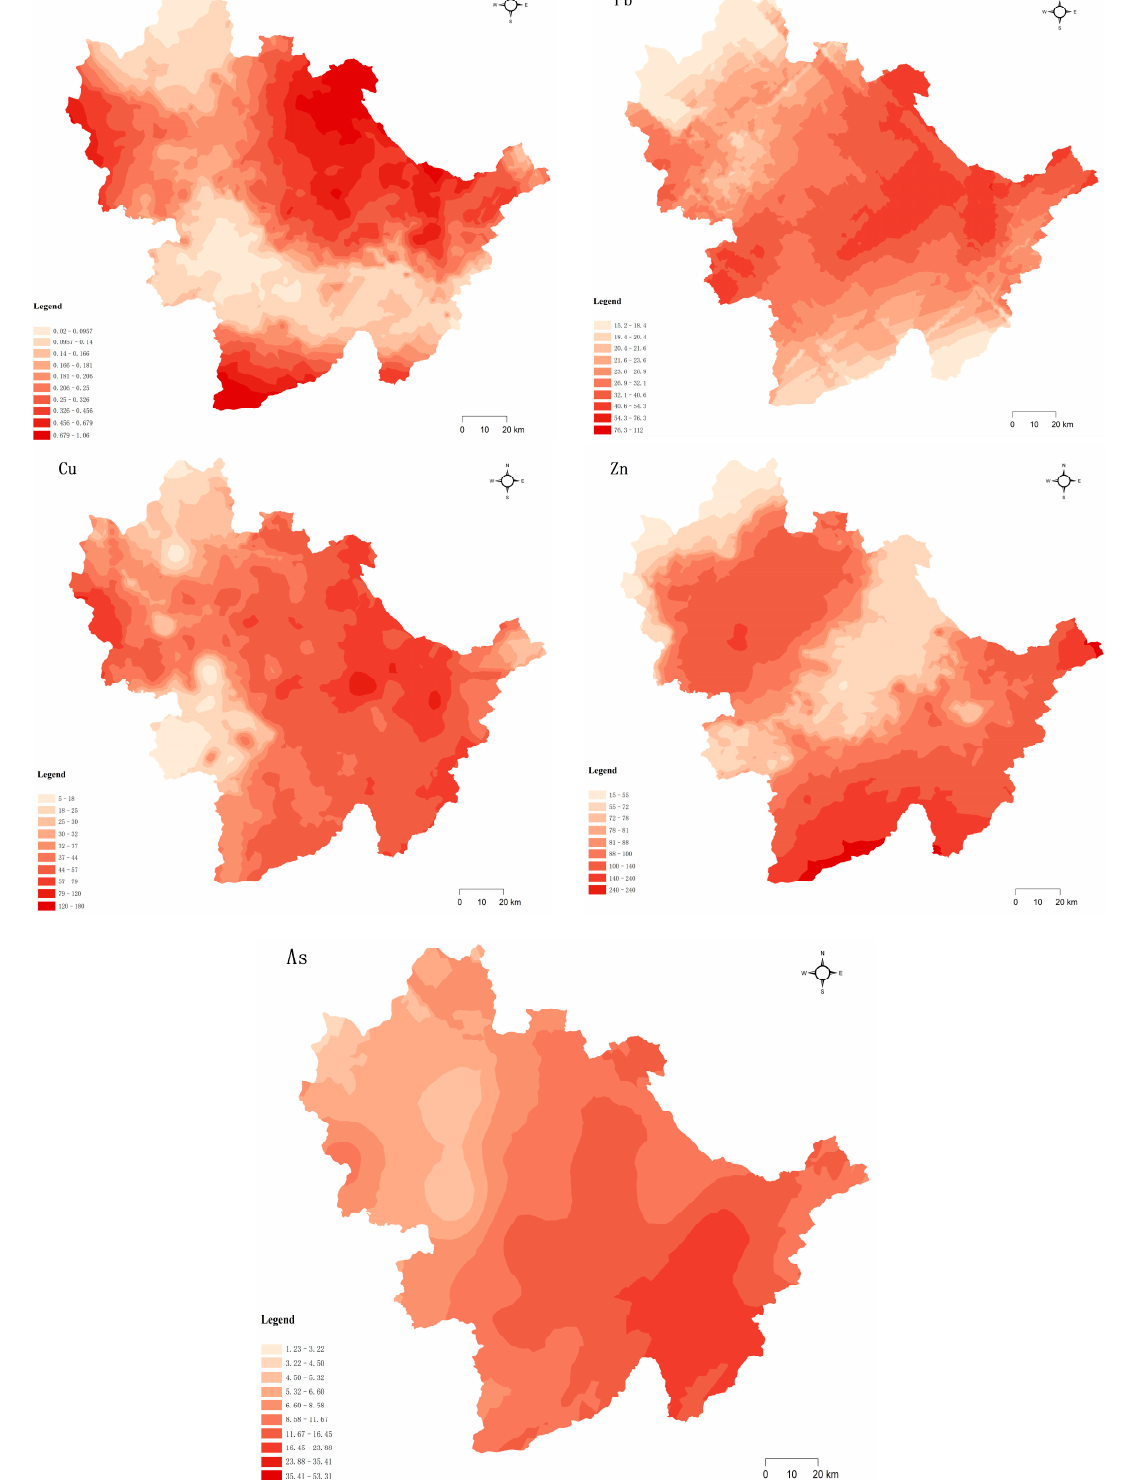
Figure 5. Spatial distribution of soil PTEs in the study area.